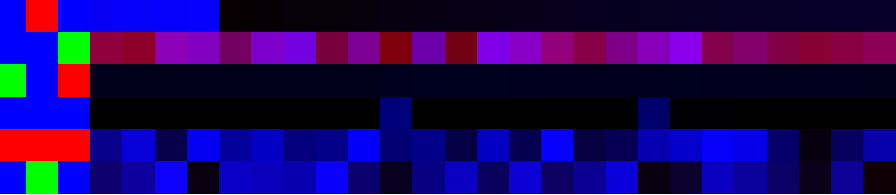
Figure 5. Example AIO for the cross-SNP set for the same accession as in Figure 4. The data on SNP and climate occupies the left and right sides of the image, respectively. The size of the image is 6 × 28 px. Here, the image is enlarged; each colored square corresponds to one pixel. The color of each pixel is obtained by (6) and (5) for genotypic and climatic factors,